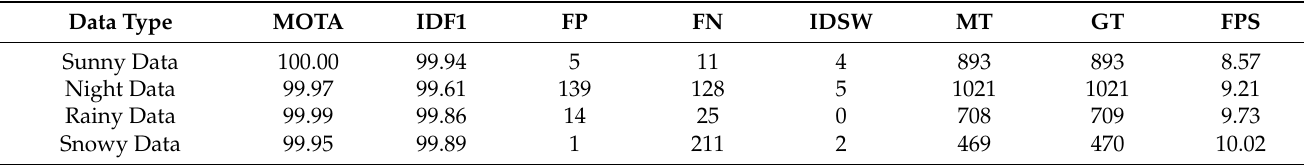
Table 12. MOT Results of SORT++ on the MWUAV dataset.